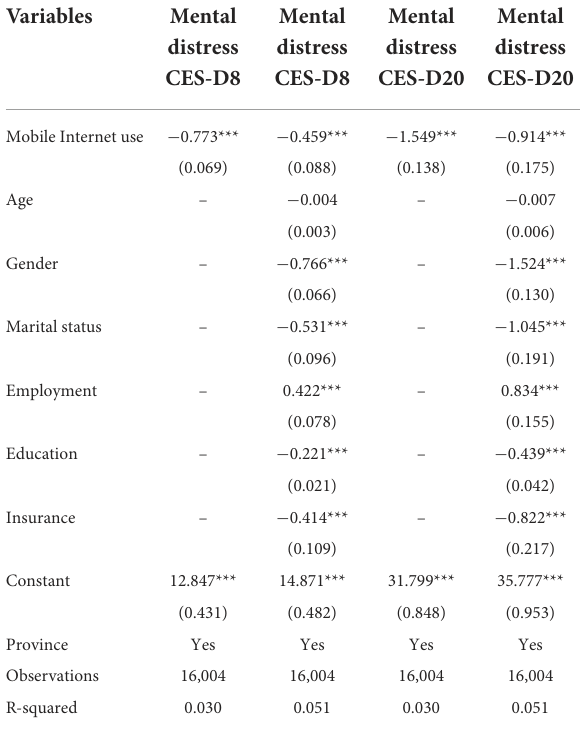
accounted for 8.9% (0.037/0.416) of the direct effect, and the variable happiness accounted for 18.18% (0.07/0.385) of the direct effect. If the dependent variable is the dummy variable distress, the mediating effect of the trust variable accounted for 9% of the direct effect, and the happiness variable accounted for 23.33% of the direct effect. If the dependent variable is the dummy variable health, the mediating effect of trust and happiness is the same as the value of the distress coefficient, but the sign is just the